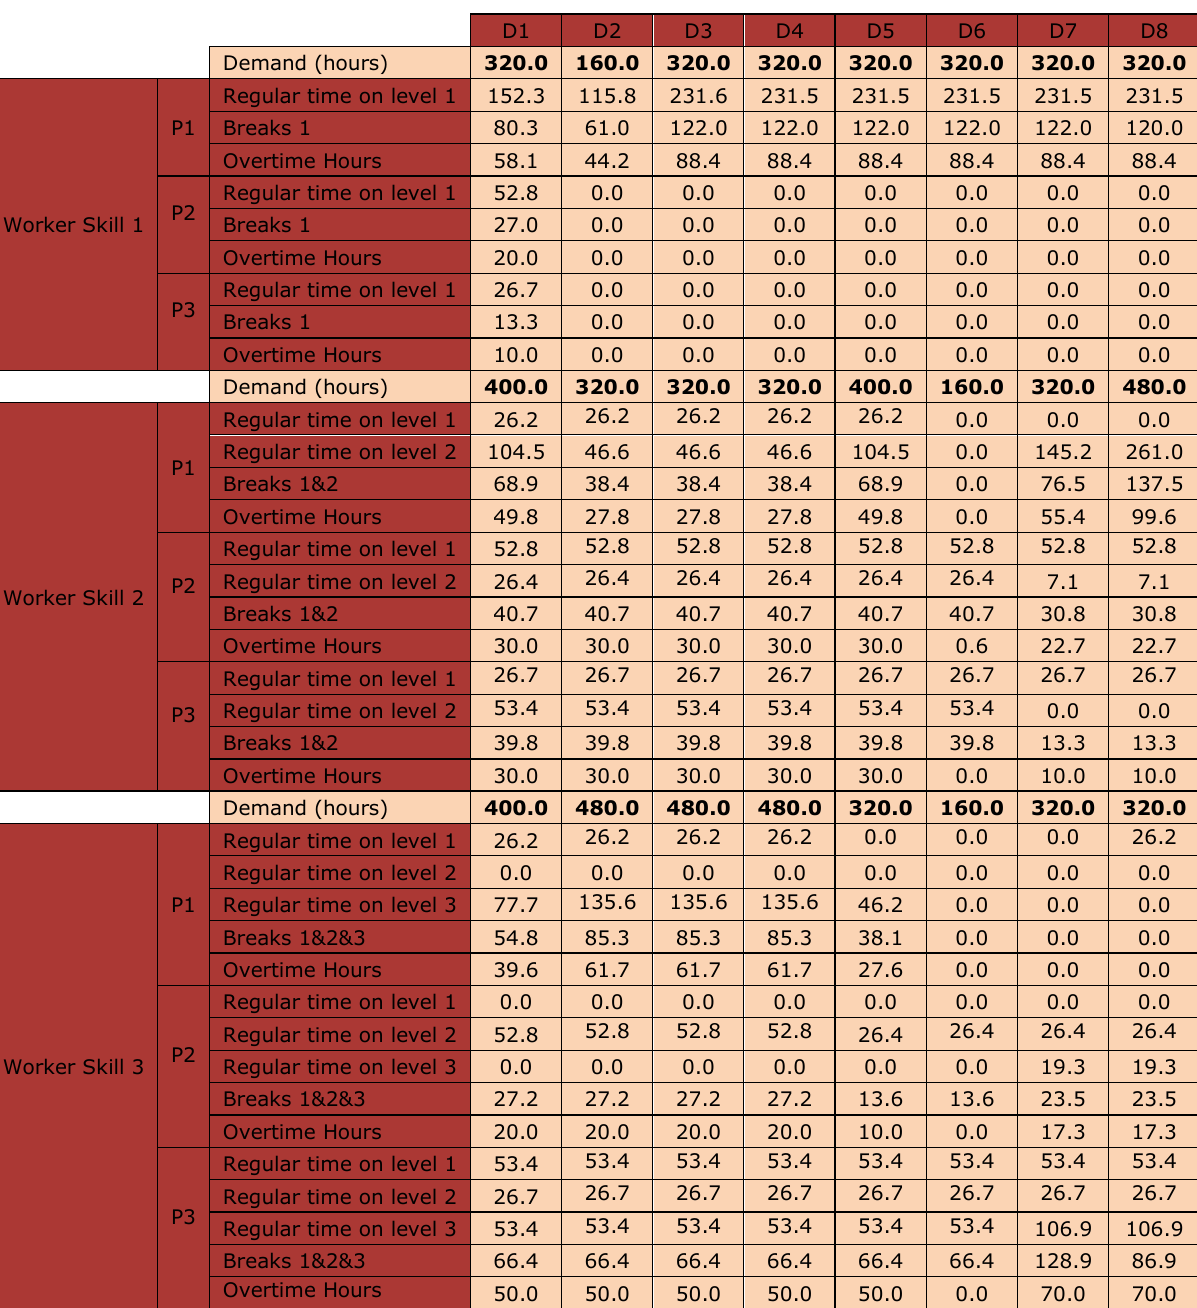
Table 9. Resulting Workforce Plan in